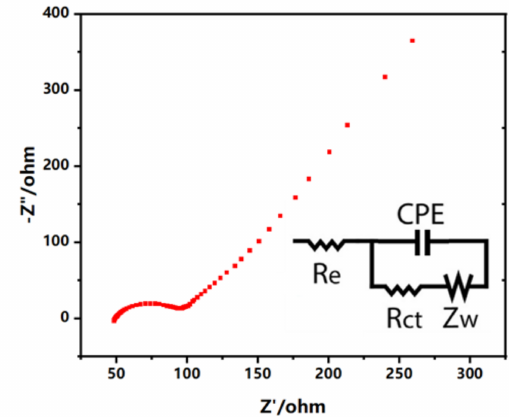
Figure 3. EIS spectra of the screen-printed electrodes obtained in 0.1 M KCl (containing 5 mM [Fe(CN) 6 ] 3-/4- ). The insert is the Randles equivalent circuit of the